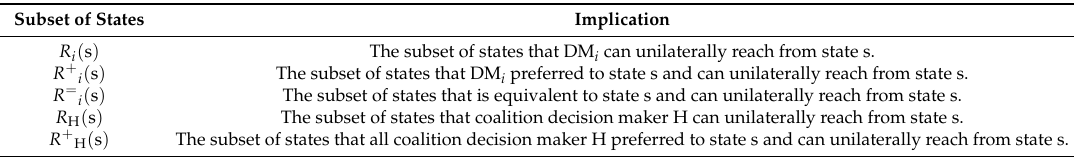
Table 1. Concepts of subsets of